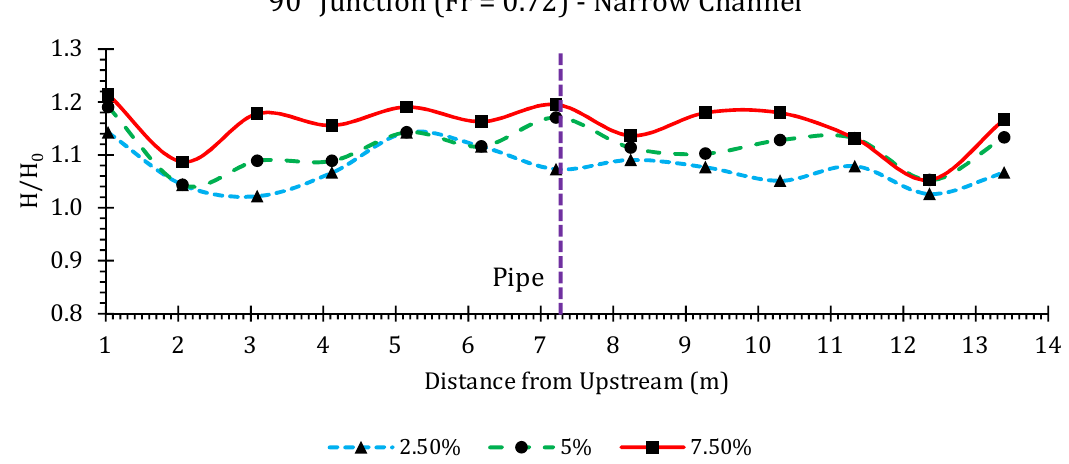
Figure A24. Water height ratios in a 90° junction for Fr = 0.72 in the narrow channel.